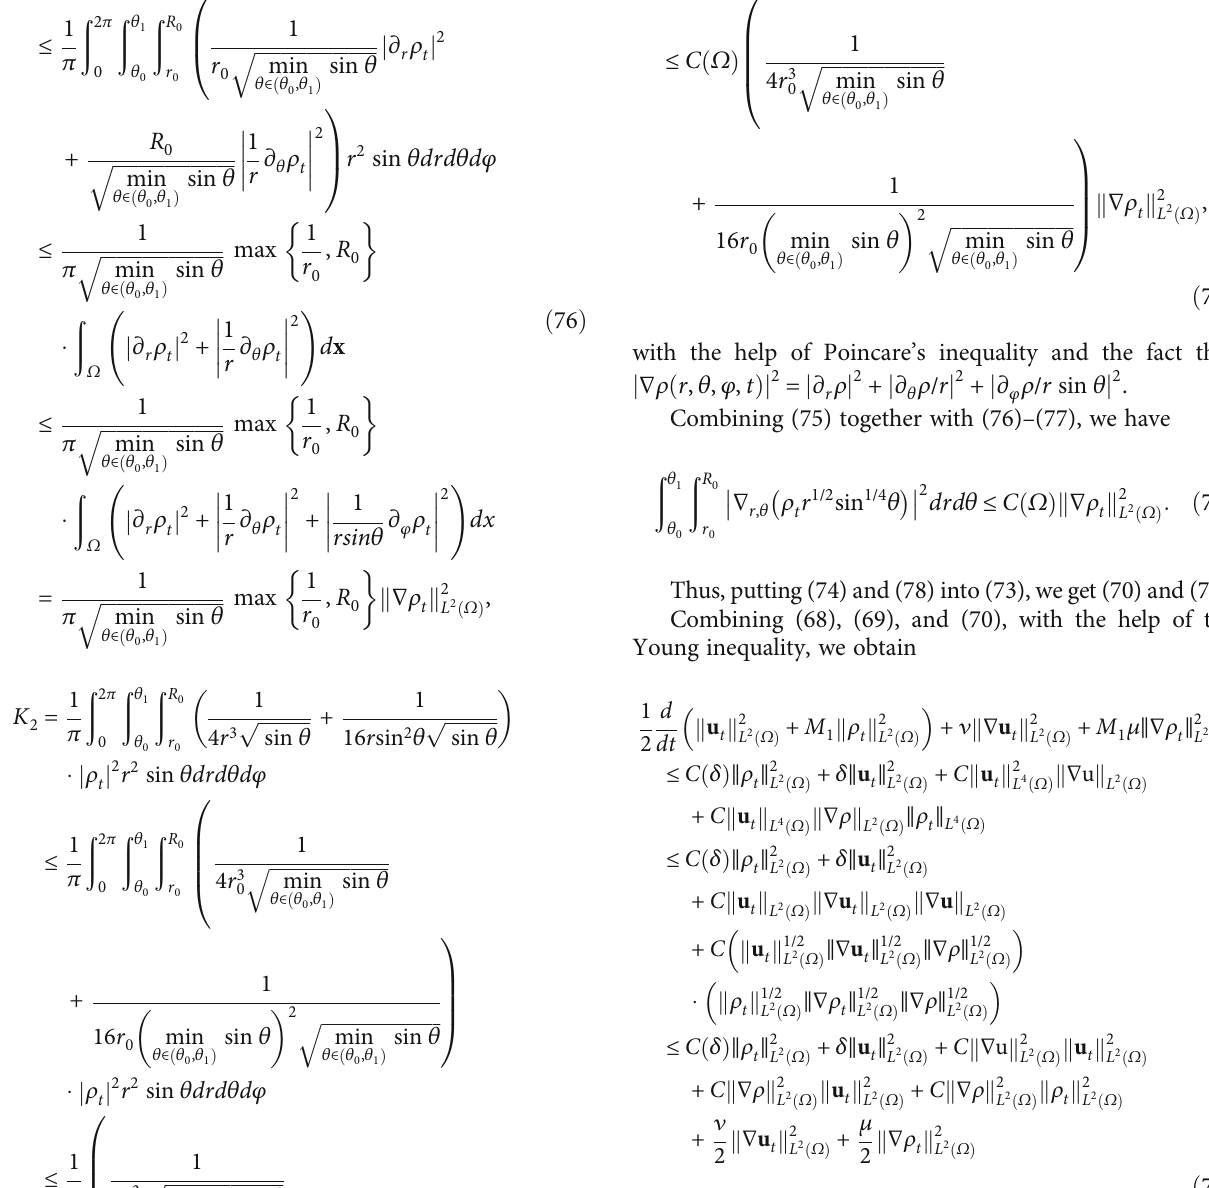
ffiffiffiffiffiffiffiffiffiffiffiffiffiffiffiffiffiffiffiffiffiffiffiffi min